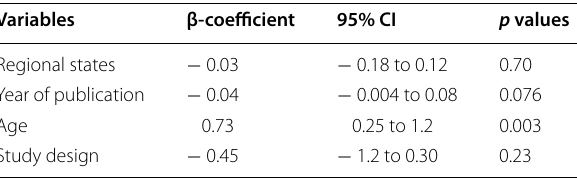
Table 2 Univariate meta-regression of factors related to the heterogeneity of soil-transmitted helminths among